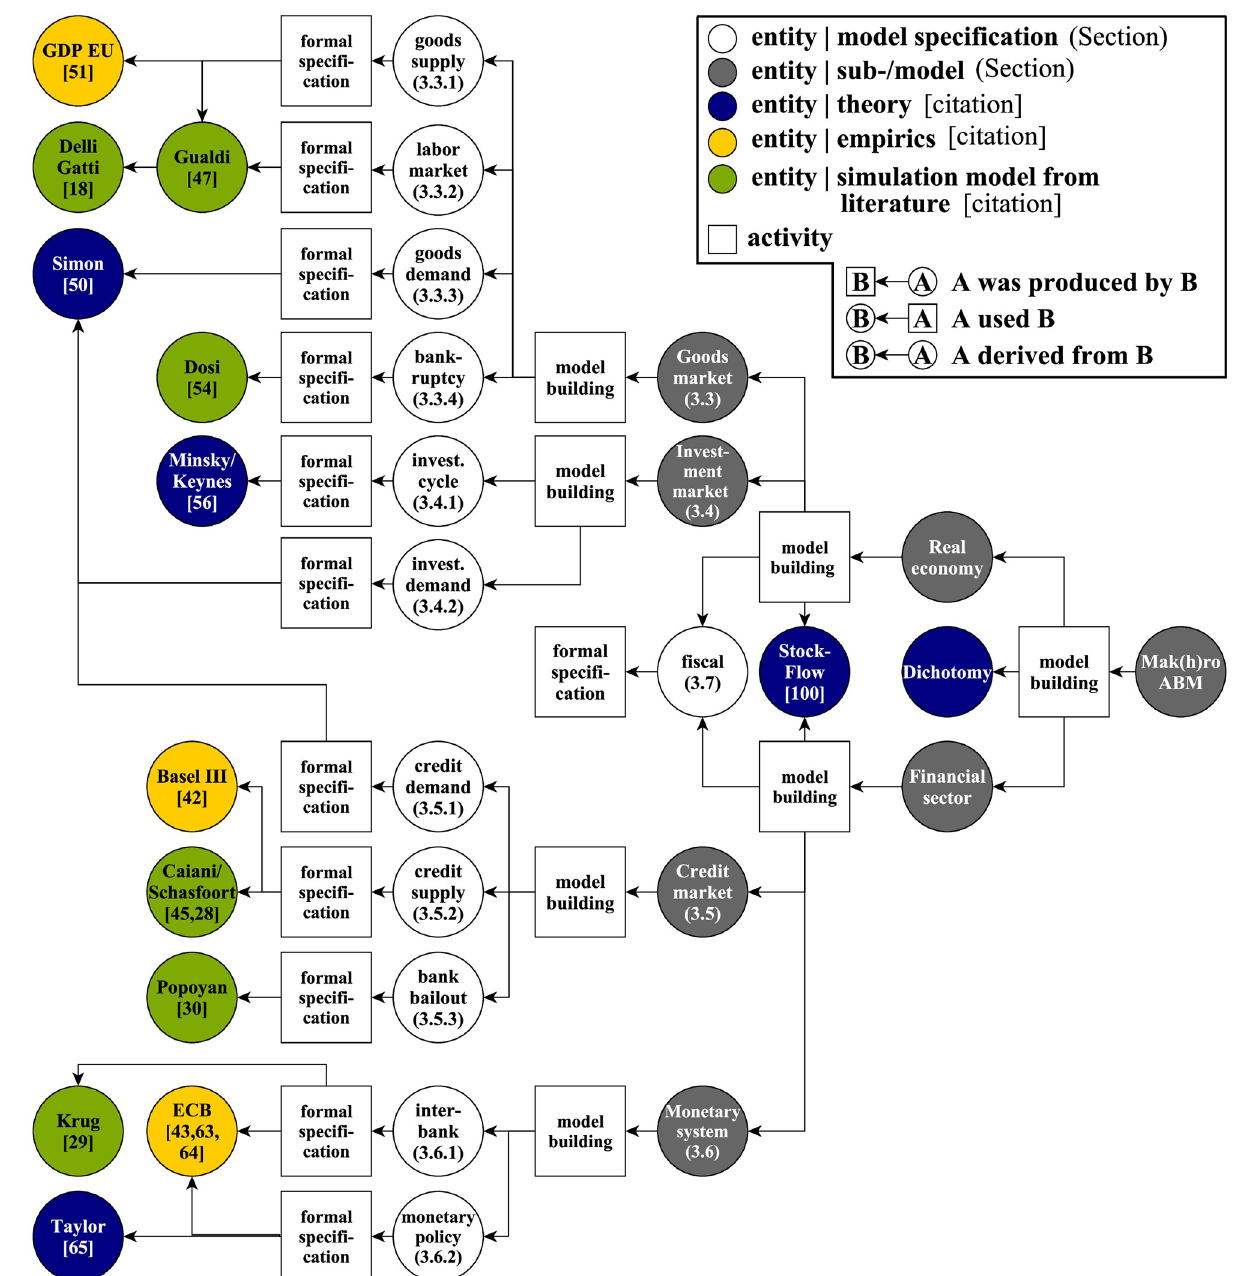
Fig 3. Provenance model. Note: The Figure shows the provenance of the composed macroeconomic agent-based model “Mak(h)ro_0” including entities from theory, empirics and simulation models from literature. Section references are labeled in parentheses and citations in brackets. For a short description of the entities and activities in this Figure, see S1